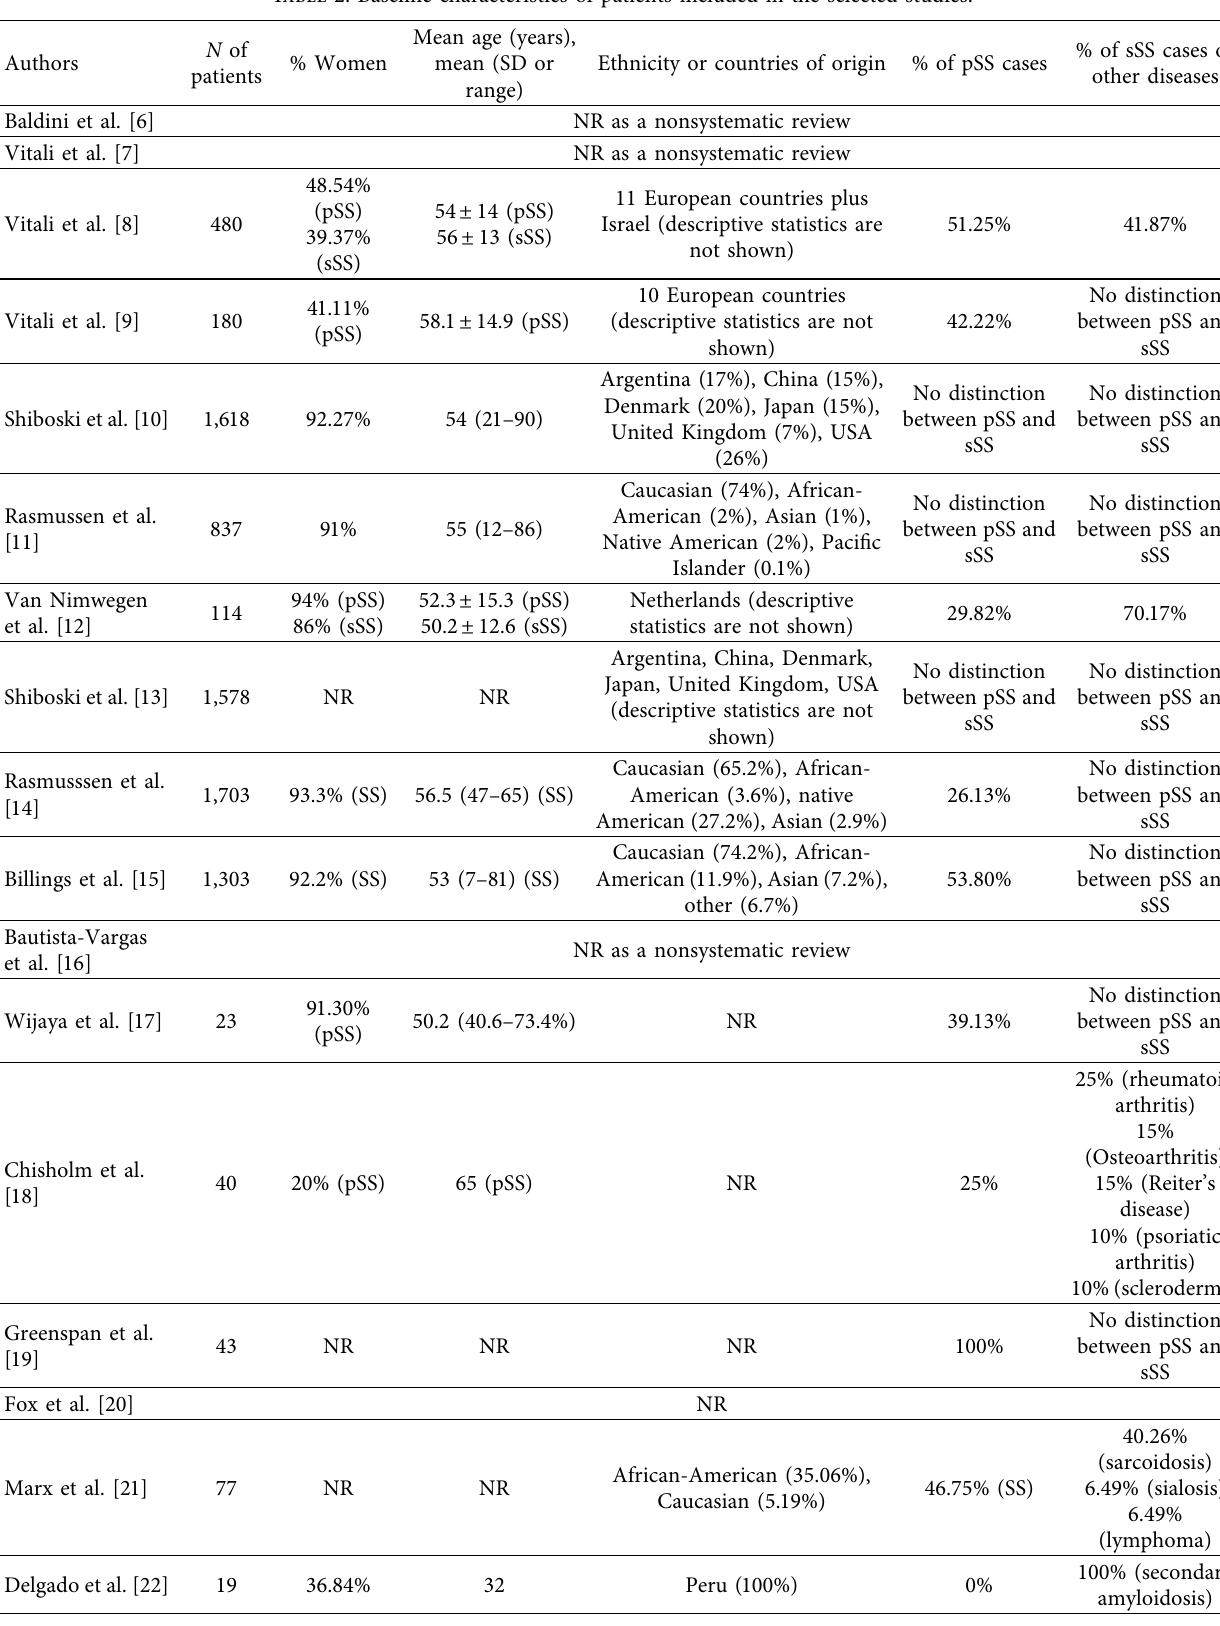
Table 2: Baseline characteristics of patients included in the selected